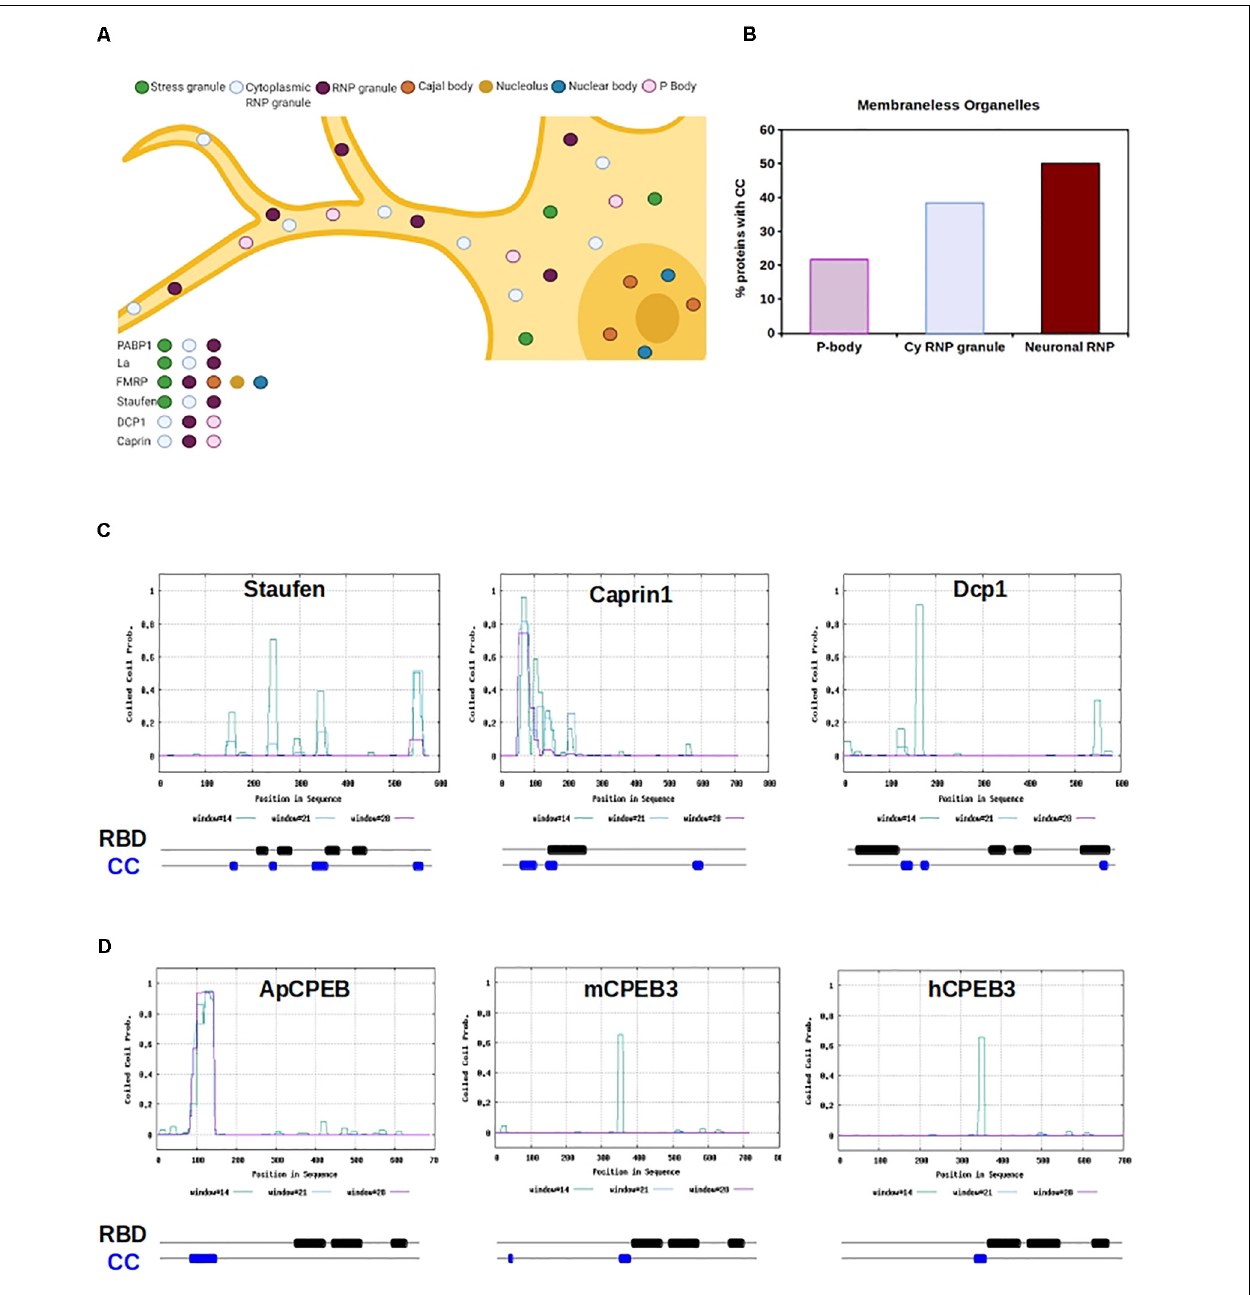
FIGURE 2 | RNA Binding Proteins with CC motifs in Membraneless organelles. (A) Graphic representation of a neuron containing several different types of molecular condensate, within the nucleus and cytosol. RBPs can shuttle form nucleus and cytosol and move from organelles depending on the cell physiological state. Example RBPs are listed, and organelle localization is color-coded. (B) The chart shows the percentage of proteins with cc motifs in RBP, based on the type of organelle. P-body, cytoplasmic RNP granule (cy RNP granule), and neuronal RNP are shown. (C) Graphical representation of CC prediction for Staufen, Caprin1, and Dcp1. Below each graph is a schematic of the organization of the RNA binding domains (RBD, black) and CC motifs (blue) is shown. RBD and CC are justaxposed, with minimal or no overlap. (D) Graphical representation of CC prediction for Aplysia CPEB, mouse CPEB and human CPEB. Below each graph a schematic of the organization of the RNA binding domains (RBD, black) and CC motifs (blue) is shown. RBD and CC are justaxposed, with minimal or no